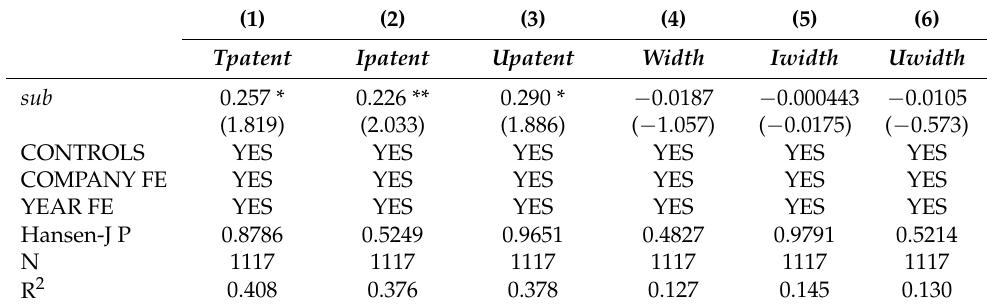
Table 5. Regression results of the endogenous test.